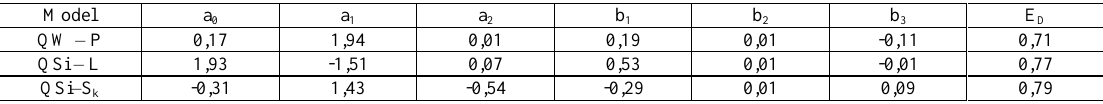
Table 6. Numerical values of the coefficients and the degree of identity for two-dimensional models.